Question: In a single sentence, describe what this figure presents.
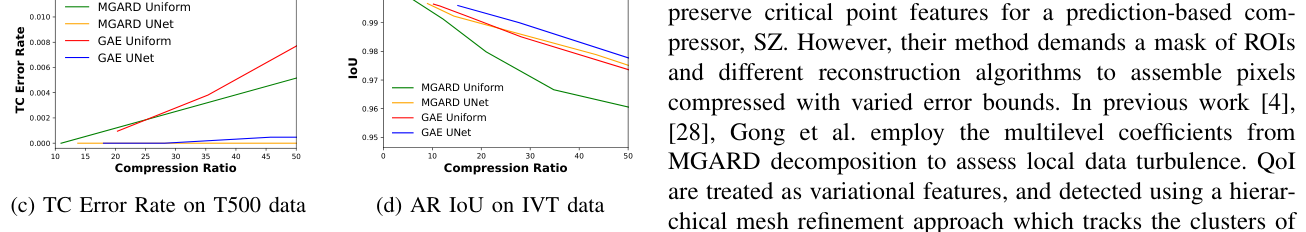
Answer: QoI error for TC and AR. These results show that GAE with UNet is able to achieve higher compression ratio while achieving comparable or better accuracy to other methods.